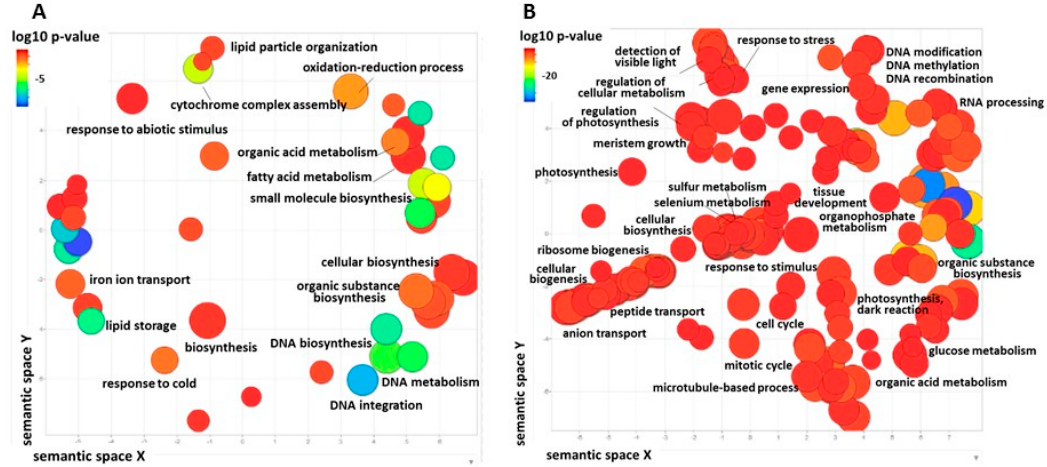
Figure 6. Biological processes in imbibed and in stratified seeds of A. sativum revealed by GO term distribution analysis using Blast2Go and REViGO algorithms. GO terms are represented by circles and are plotted according to semantic similarities to other GO terms (adjoining circles are most closely related). Circle size is proportional to the abundance of the GO terms within a cluster, while color differences indicate semantic dissimilarities. Only GO terms with higher than 1% frequency are presented. ( A ) Enriched biological processes in imbibed seeds. ( B ) Enriched biological processes in stratified seeds.